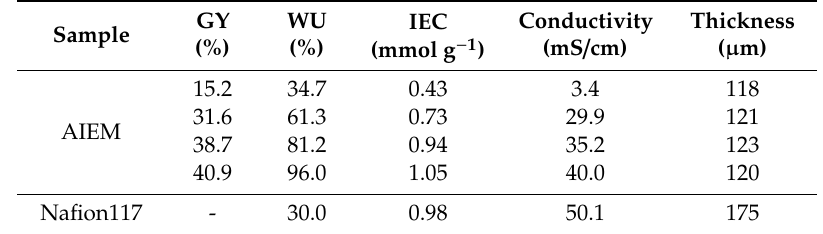
Table 2. The water uptake, IEC, conductivity and thickness of AIEM with different GY and Nafion117 membrane.